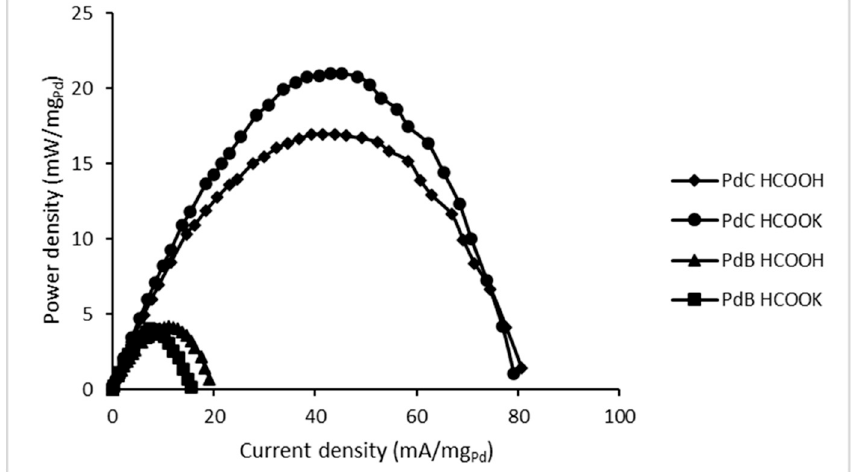
Figure 6. Formate/formic acid fuel cells’ performances. Figure 6. Formate / formic acid fuel cells’